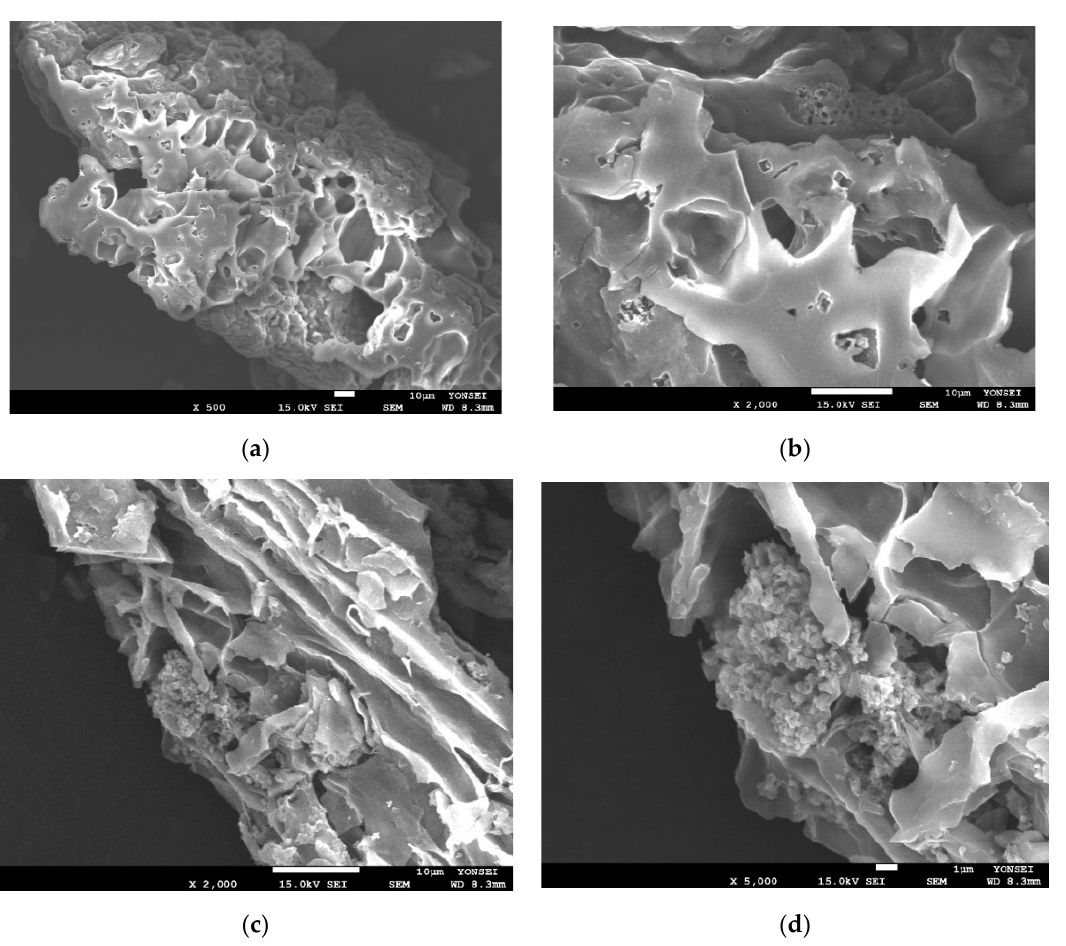
Figure 5. Scanning electron microscopy analysis before and after the biochemical methane potential test ( a ) before, ×500; ( b ) before, ×2000; ( c ) after, ×2000; and ( d ) after, ×5000.